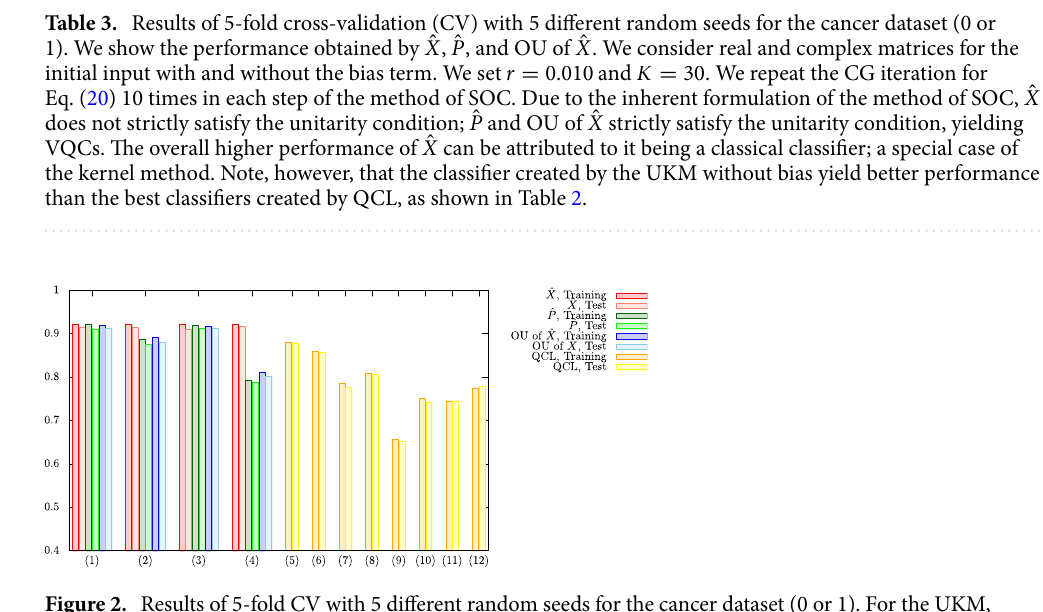
Figure 2. Results of 5-fold CV with 5 different random seeds for the cancer dataset (0 or 1). For the UKM, we put r = 0.010 and K = 30 ; see the appendix for the definitions of r and K . We repeat the CG iteration for Eq. (20) 10 times in each step of the method of SOC. For QCL, the number of layers L is 5 and the number of iterations is 300. The numerical settings are as follows: (1) UKM: complex matrix without bias, (2) UKM: complex matrix with bias, (3) UKM: real matrices without the bias term, (4) UKM: real matrices with the bias term, (5) QCL: CNOT-based circuit without the bias term, (6) QCL: CNOT-based circuit with the bias term, (7) QCL: CRot-based circuit without the bias term, (8) QCL: CRot-based circuit with the bias term, (9) QCL: 1d Heisenberg circuit without the bias term, (10) QCL: 1d Heisenberg circuit with the bias term, (11) QCL: FC Heisenberg circuit without the bias term, and (12) QCL: FC Heisenberg circuit with the bias